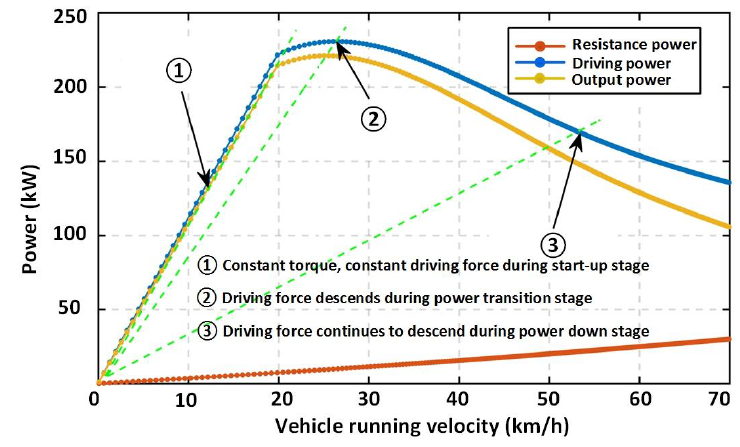
Figure 10. HFC vehicle power system driving power-resistance power balance diagram.